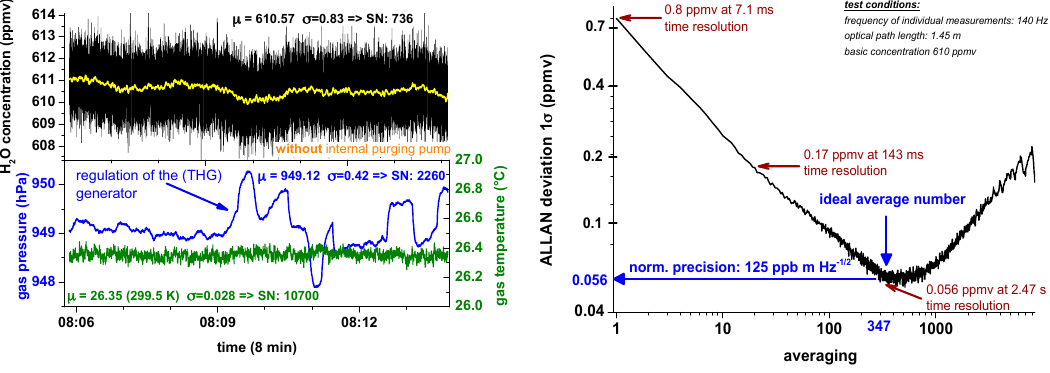
Figure 8. Left : H 2 O concentration measurements for the Allan variance plot ( Right ) with corresponding pressure and temperature values; Right : The Allan variance plot demonstrated under these test conditions an achieved precision of 0.8 ppmv at 140 Hz (no average), 0.17 ppmv at 7 Hz (standard operation mode of SEALDH-II) and a lowest achievable precision (=optimal precision) of 0.056 ppmv at 0.4 Hz.